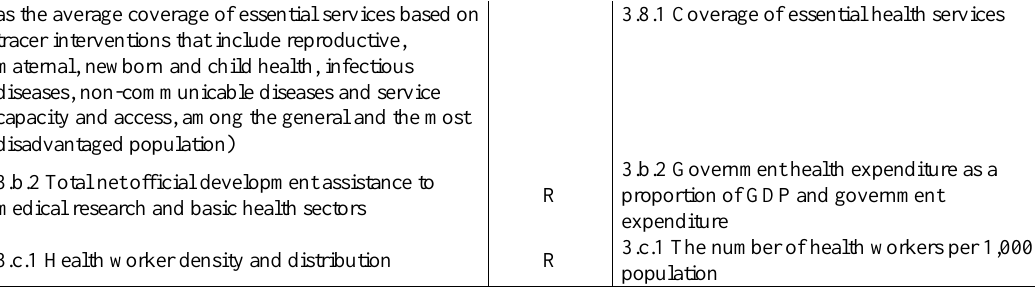
Table 1. SDG 3 localization